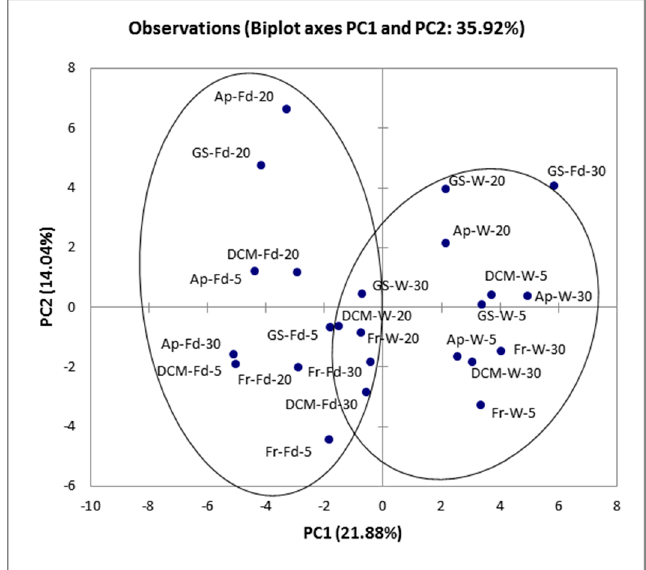
Figure 2. Principal component analysis (PCA) plot of minor volatiles isolated by low alcohol wines fermented by wet or freeze-dried free or immobilized kefir culture. Fr: low alcohol wine fermented by free kefir culture, Ap: low alcohol wine fermented by immobilized kefir culture on apple pieces, DCM: low alcohol wine fermented by immobilized kefir culture on delignified cellulosic material (DCM), GS: low alcohol wine fermented by immobilized kefir culture on grape skins. The state of the cells is referred as W: Wet cells or Fd: Freeze-dried cells, after the sample’s name. The fermentation temperature is indicated at the end of the sample code.